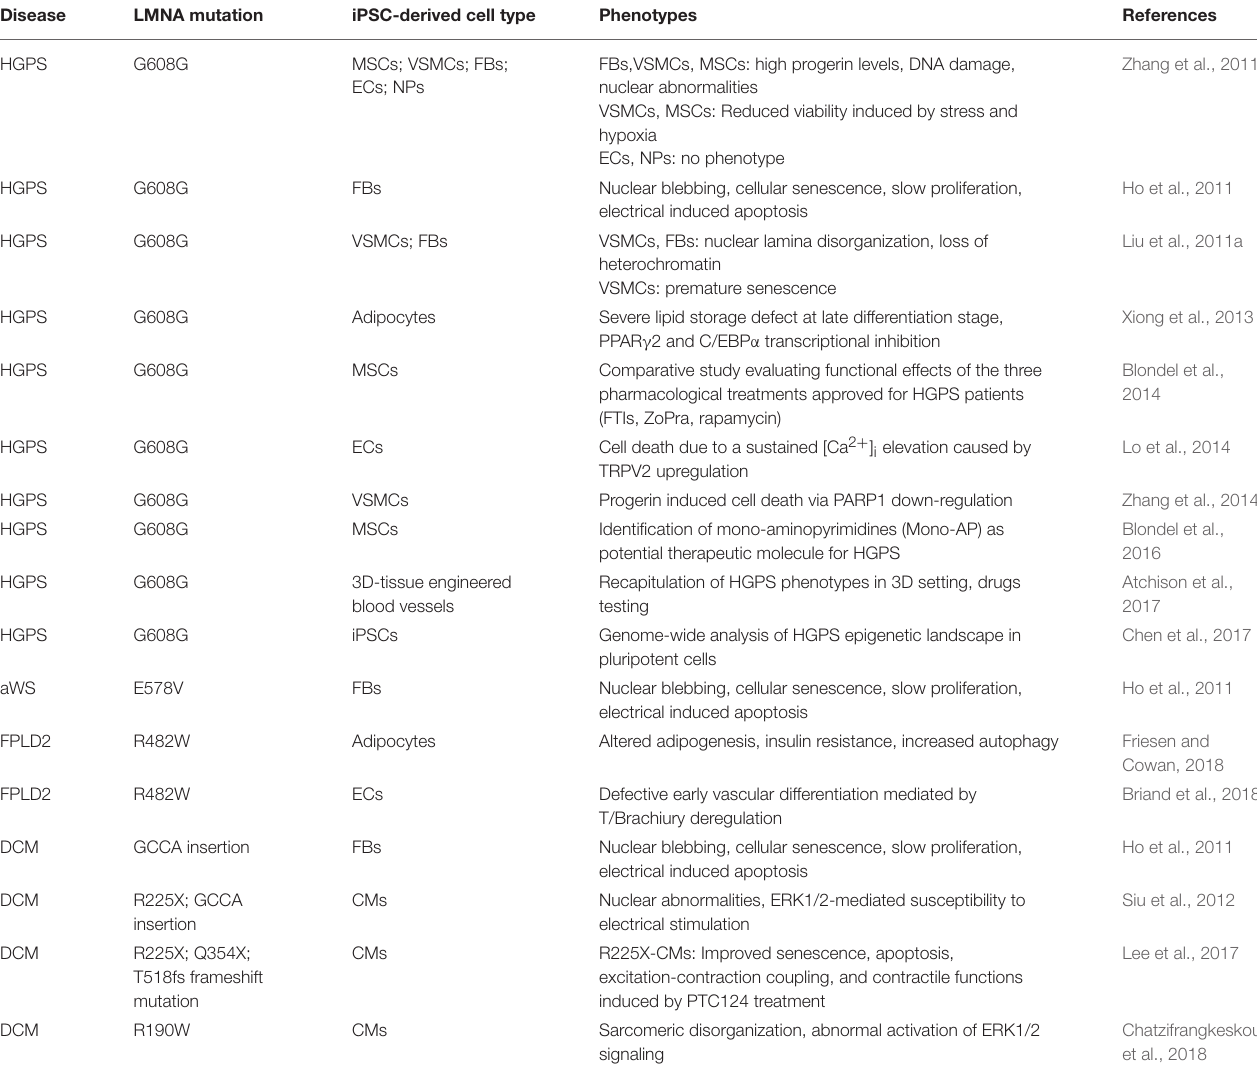
TABLE 2 | iPSC-based models of laminopathies.